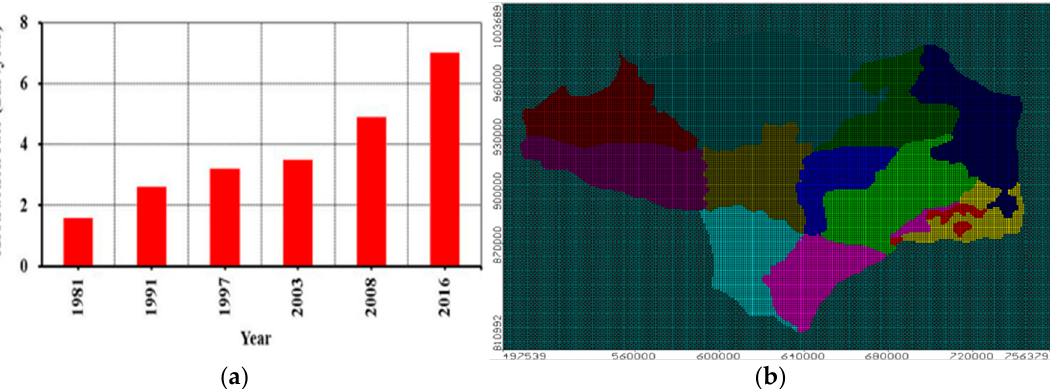
Figure 2. ( a ) Annual abstraction rates from the Nile Delta aquifer [32], ( b ) Recharge from the Nile Delta [13] .